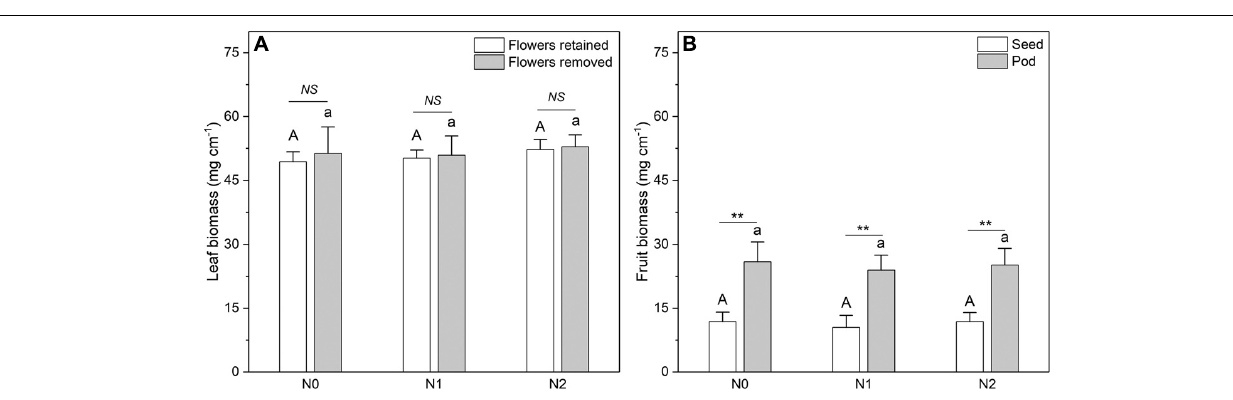
TABLE 1 | The significance results ( P -values) for two-way ANOVA for the effects of N addition (N) and sink decrease (FR, flower removal) on leaf N concentration and N resorption efficiency ( NRE ).